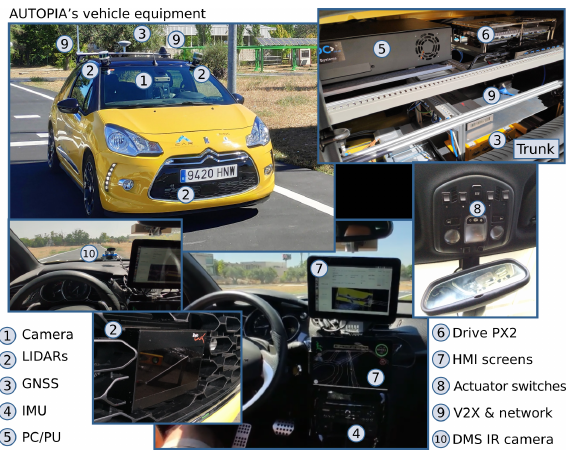
Figure 15. Modules of the autonomous vehicle of AUTOPIA